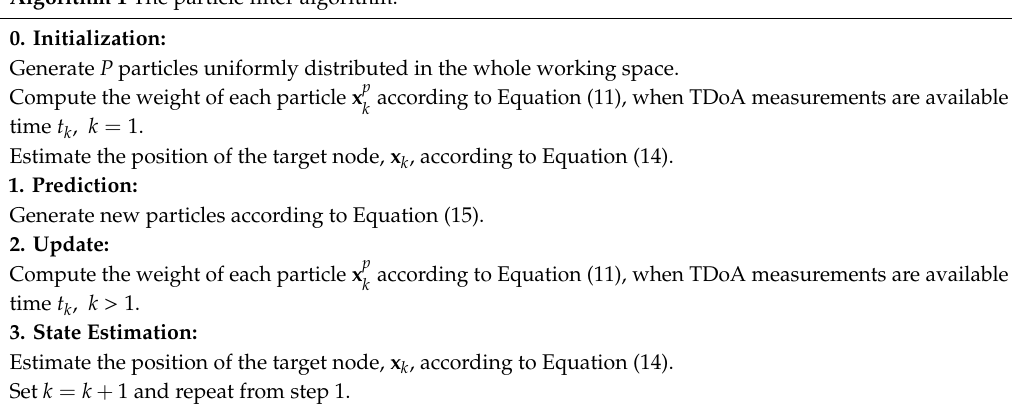
Algorithm 1 The particle filter